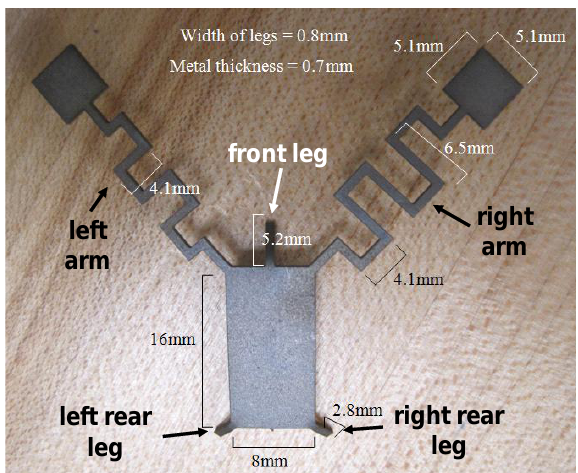
Figure 1. Top view of a